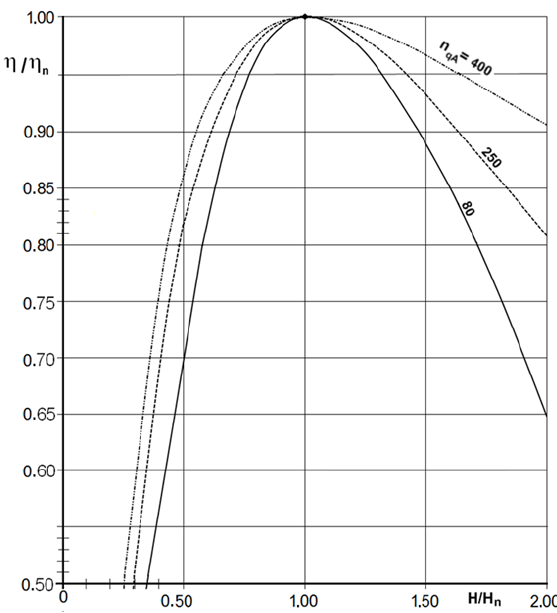
Figure 7. Efficiency curves of Francis runners as a function of the normalized head. Figure 7. E ffi ciency curves of Francis runners as a function of the normalized head.